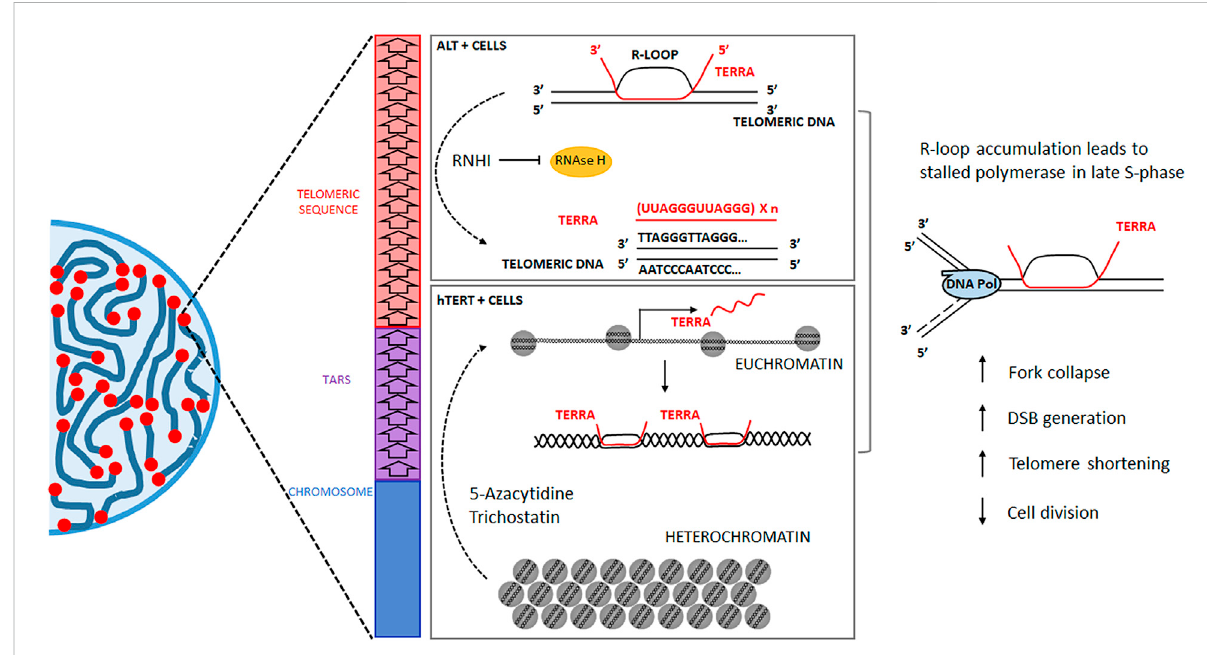
FIGURE 3 The telomeres in eukaryotic cells protect the extremes of the linear chromosomes. Note that the canonical telomeric sequence (5 ′ -TTAGGG- 3 ′ ) degenerates into associated repeats towards the chromosome sequence. The lncRNA TERRA forms R-Loops in the telomeric tract to increase telomere protection. Still, a potential therapeutic application can derive from R-Loop accumulation by inducing senescence/apoptosis. hTERT + tumor cells treated with 5-azacytidineor trichostatin will increase TERRA transcription; ALT + tumor cells treated with RNHIs will not be ableto dismantle DNA/RNA hybrids. Both treatments can lead to telomeric R-Loop accumulation, DNA damage, telomere shortening, and arresting cell